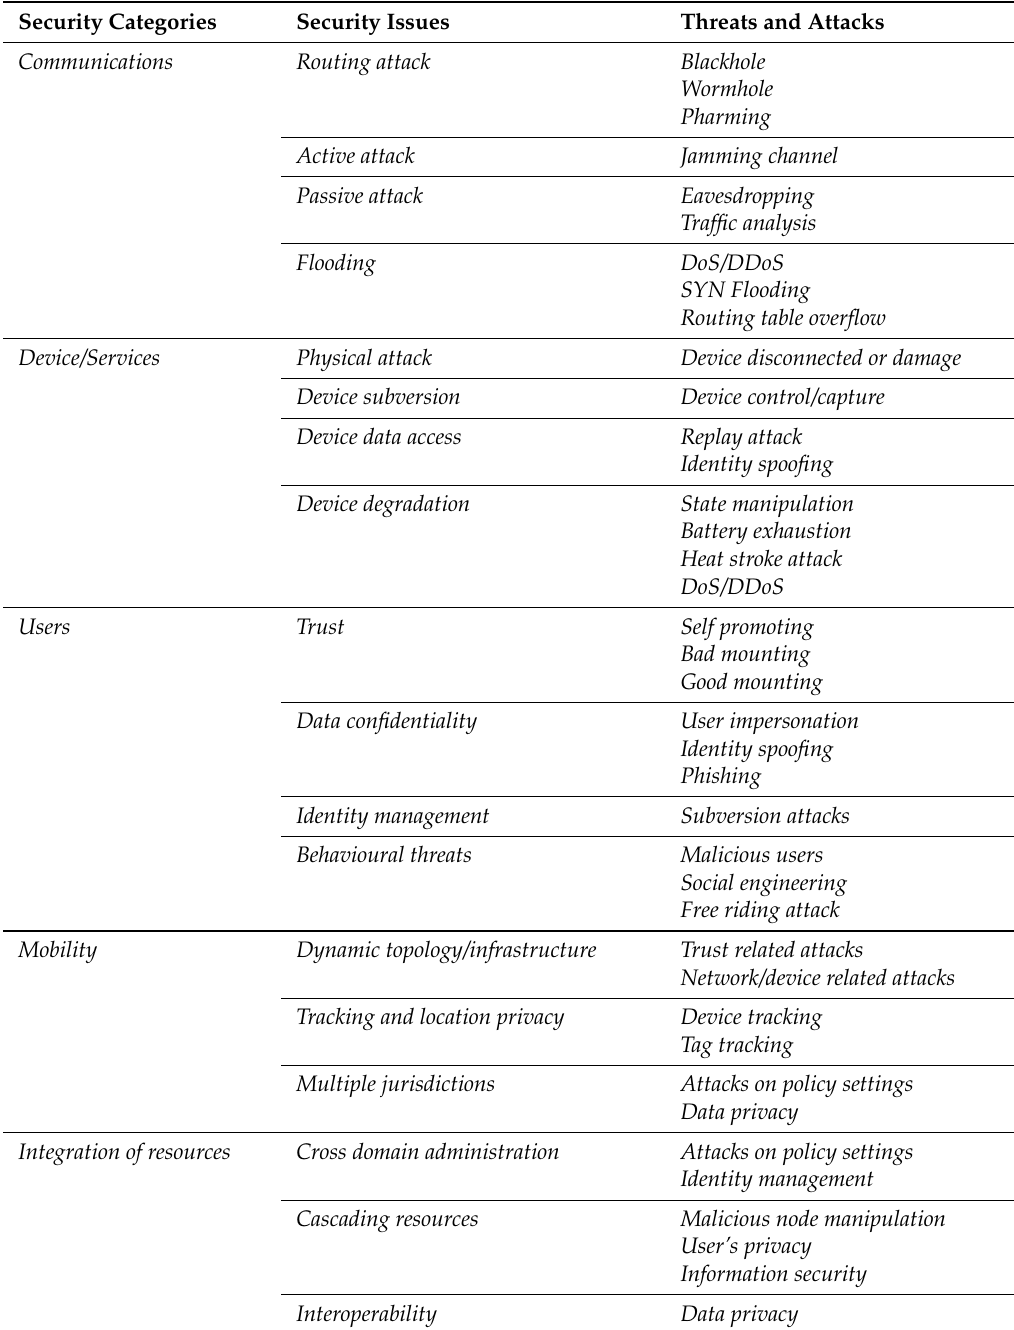
Table 3. Devised threats and attacks categories and related security